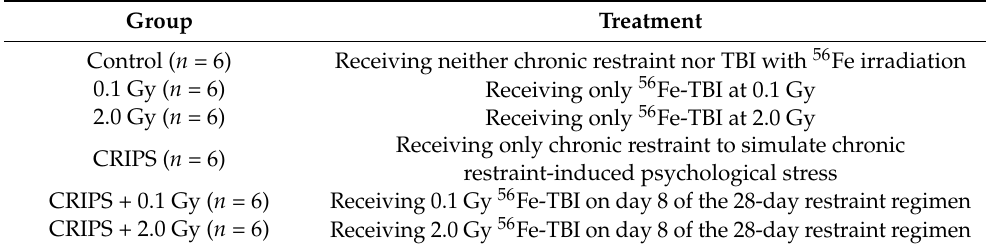
Table 1. Experimental group. Group Treatment Control ( n = 6) Receiving neither chronic restraint nor TBI with 56 Fe